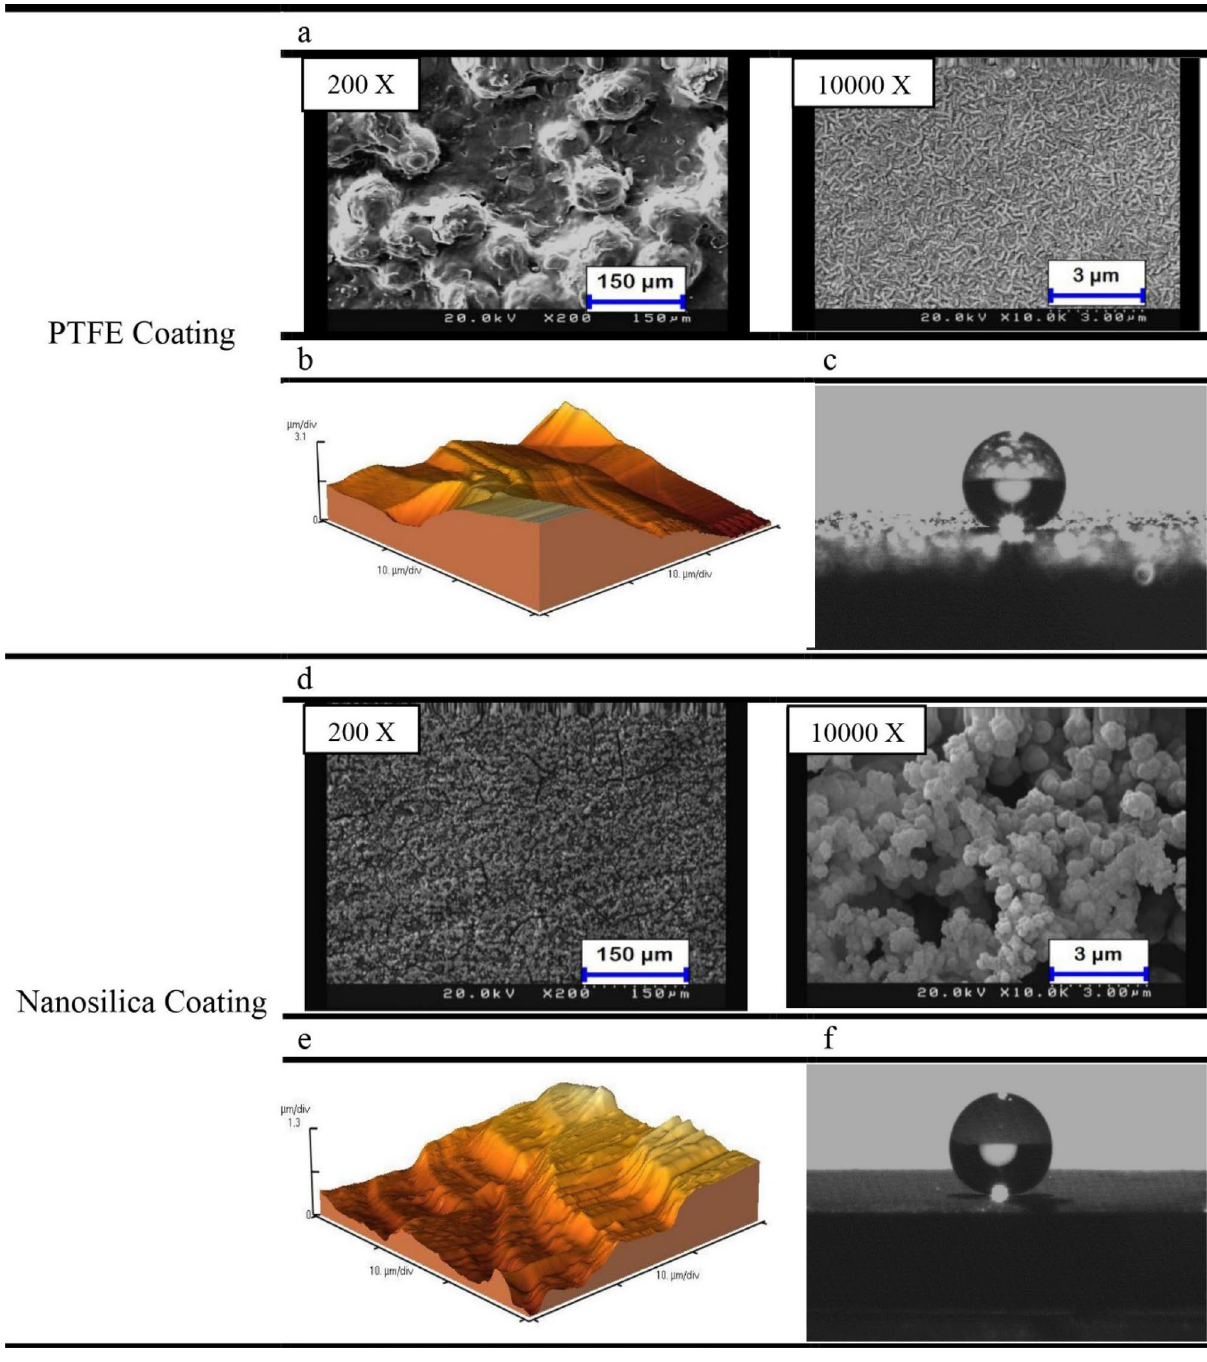
Figure 1. ( a , d ) SEM images and ( b , e ) images of 3D AFM (10 × 10 µm 2 ) and ( c , f ) WCA images for PTFE and nanosilica